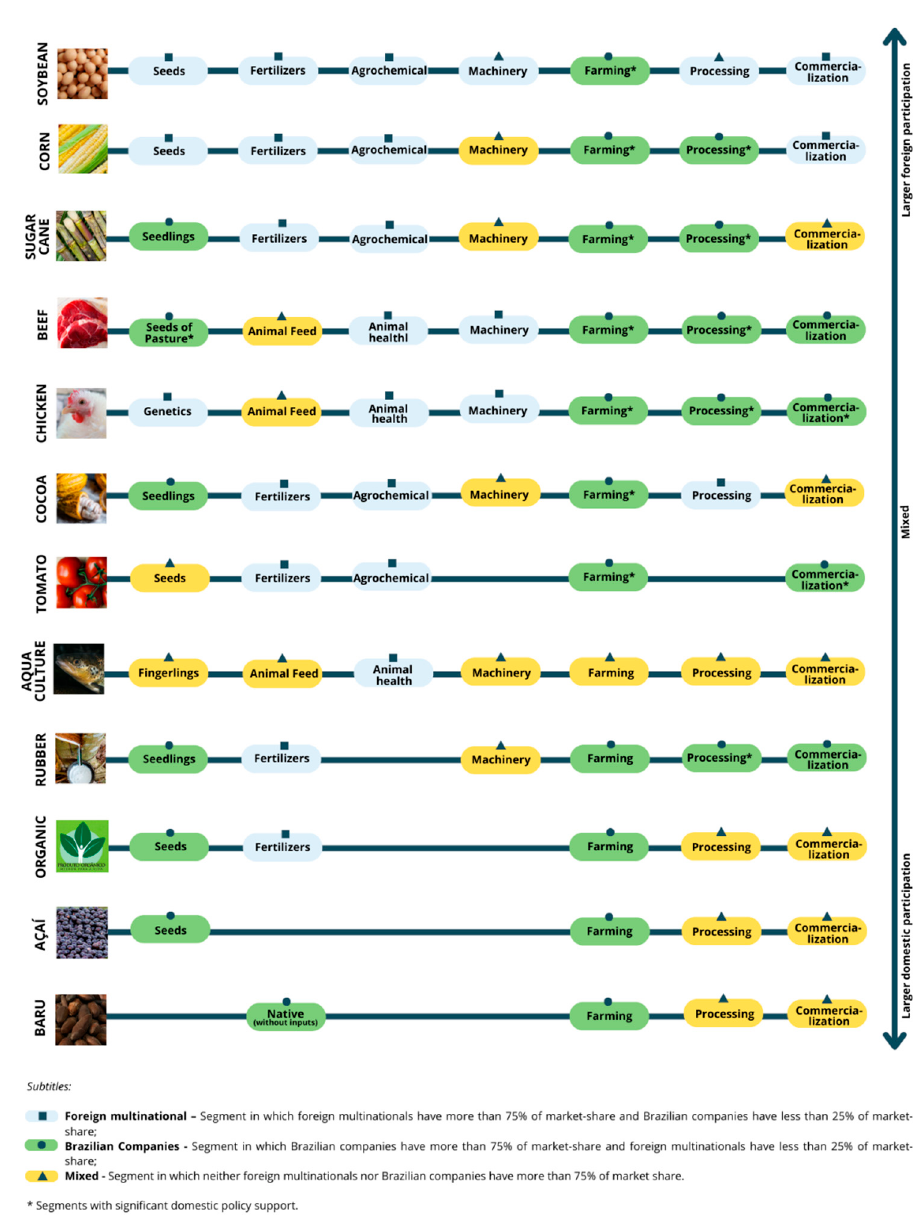
Figure 1. Participation of Brazilian and foreign economic groups in key segments of the supply chains analysed.